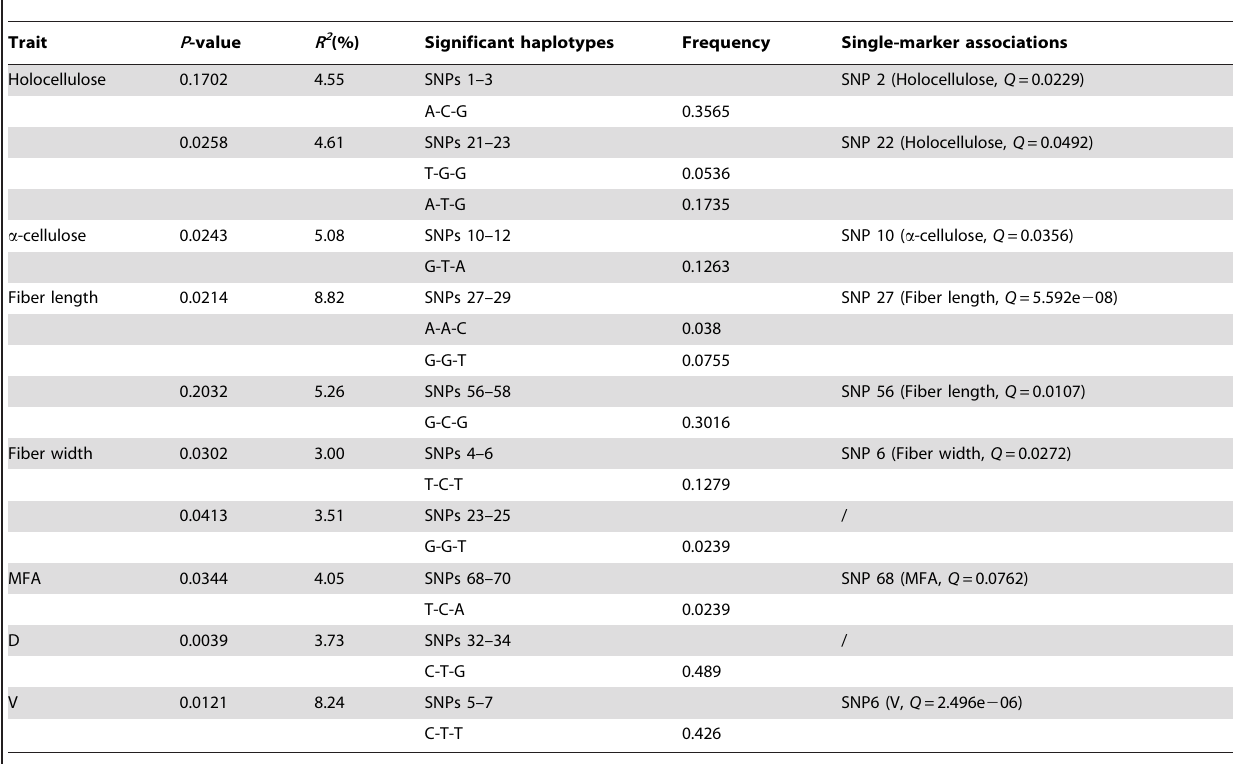
Table 6. Haplotypes significantly associated with growth and wood property traits.